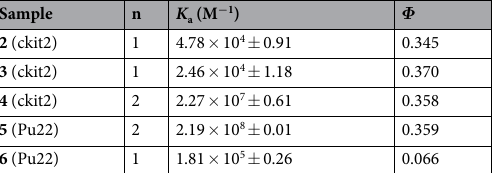
Table 2. Binding stoichiometry [putative number of binding sites on ckit2 ( n )], apparent binding equilibrium constants ( K a ), and fluorescence quantum yields ( Φ ).